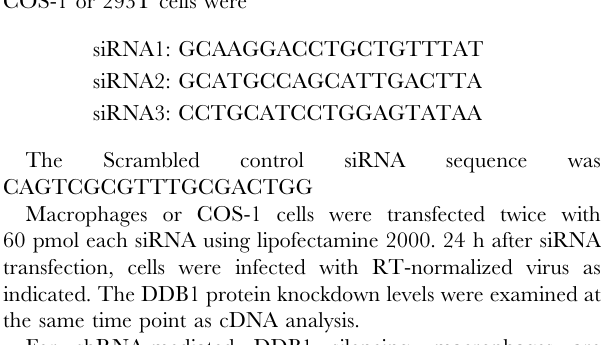
Figure S1 Susceptibility of macrophages to infection by wild type and Vpx-deleted SIV SM variants. Virus infection was gauged from the levels of late cDNA and 2-LTR cDNA products of reverse transcription at 24 and 48 h post infection. Figure S2 Differential impact of proteasome inhibition on HIV- 2 WT infection of macrophage and COS cells. Effects of three different proteasome inhibitors on HIV-2 infection are indicated. Viral infection (2-LTR cDNA) was gauged 24 and 48 h post infection (error bars are s.d. of 3 replicate measures of a single sample). Figure S3 Differential impact of shRNA-mediated DDB1 silencing on infection of primary macrophages by SIV and HIV- 1. (A) DDB1 expression in primary macrophages at 72 and 96 hours post infection with a lentivirus vector expressing a DDB1 shRNA. Control cells were infected with a non shRNA expressing lentivirus vector. (B) SIV cDNA and HIV-1 cDNA levels in SIV and HIV-1 infected macrophages 96 h after transduction with lentivirus vectors expressing a DDB1 shRNA or 96 h after transduction with a vector control. Infections done in the presence of AZT were used to assess the level of carry over viral DNA